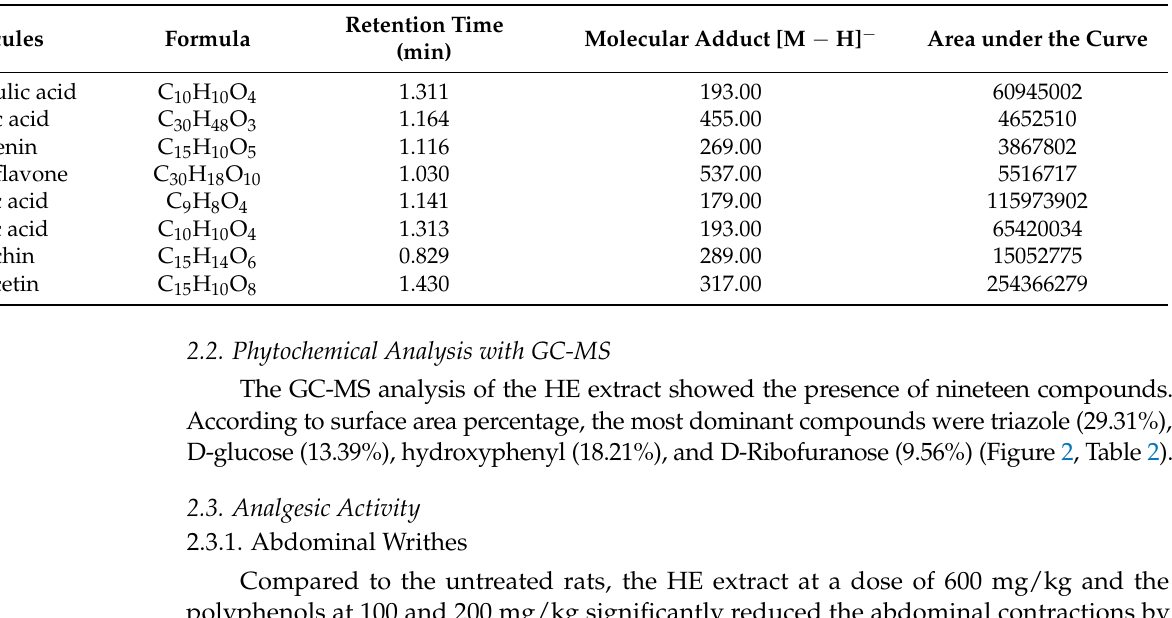
Figure 1. LC-MS/MS chromatogram of the hydro-ethanolic extract of L. officinalis Chaix. Table 1. L. officinalis Chaix’s identifying composition with LC-MS/MS.